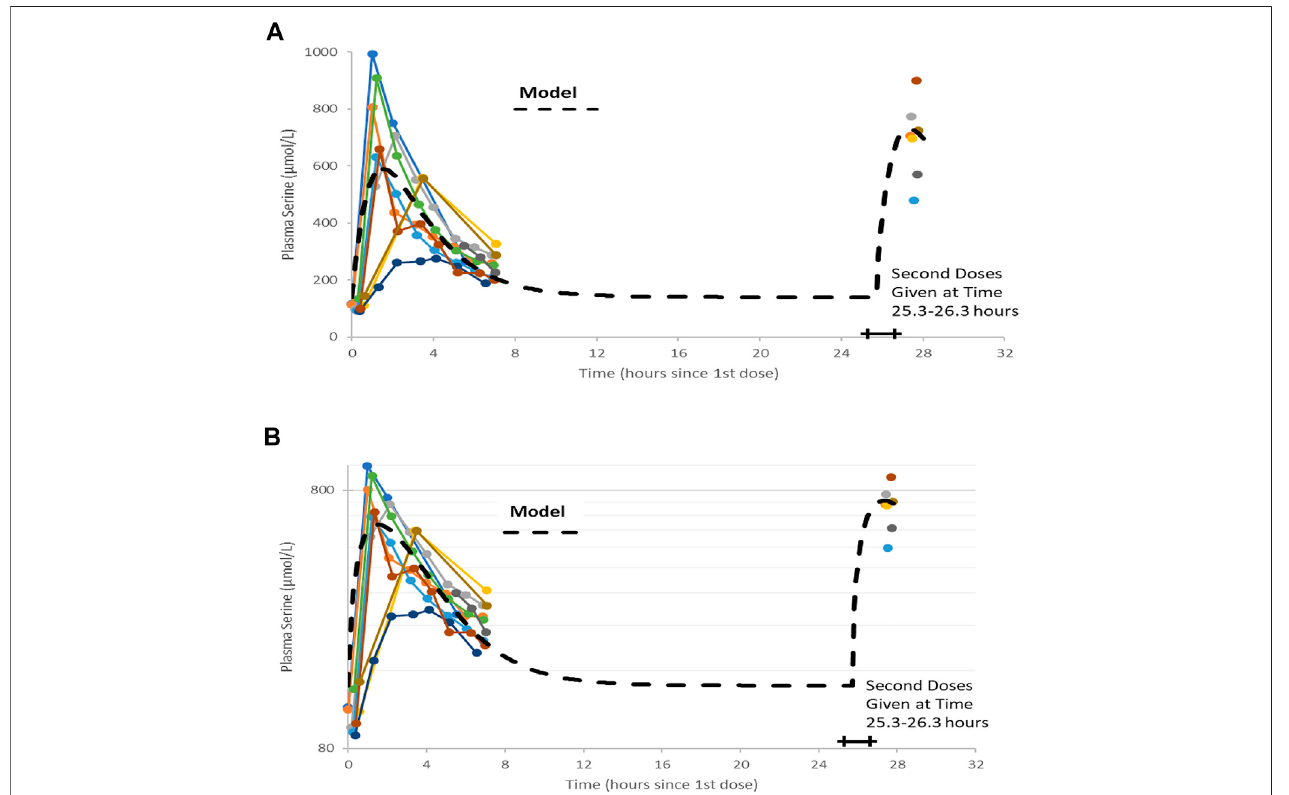
FIGURE 2 | Plots of data, time-shifted so that the initial dose time is 0 h. This resulted in the second dose time varying between 25.3 and 26.3 h, shown as a horizontalbarin fi gures.Anaïvepooledmodel(dashedblackline)isplottedwiththeindividualdata(coloreddotsandsolidlines). (A) Linearplot. (B)